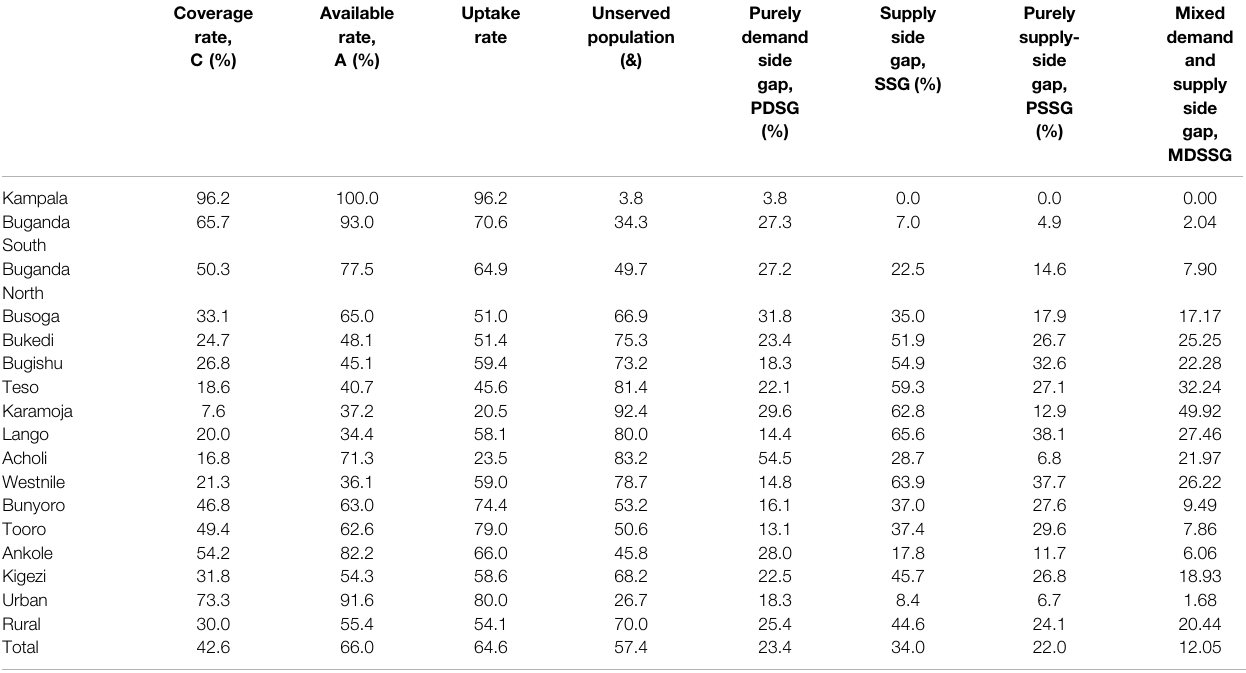
TABLE 1 | Estimation of Electricity access without controls of demand and supply-side obstacles in Uganda